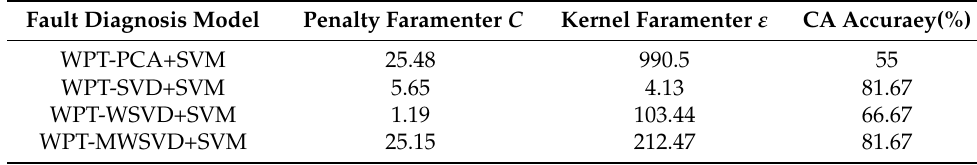
Table 3. The optimal parameters of